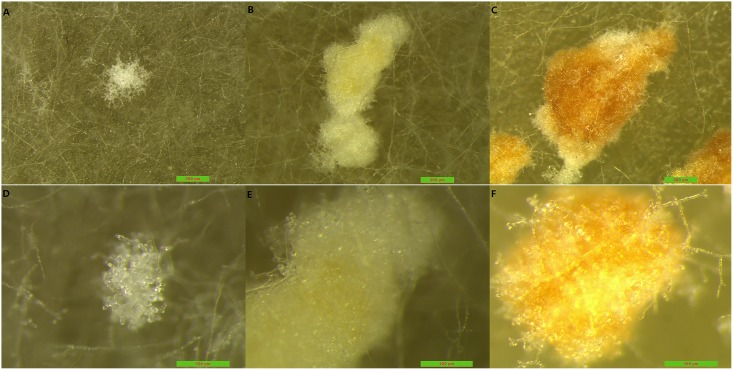
Process of sclerotia formation in PDA media under stereomicroscope.(A~ C) The sclerotia are in the early, middle and late stages, respectively (5x) and (D~F) represent the same stage under 16 ×; The color of sclerotia were from white to faint yellow and final in brown.